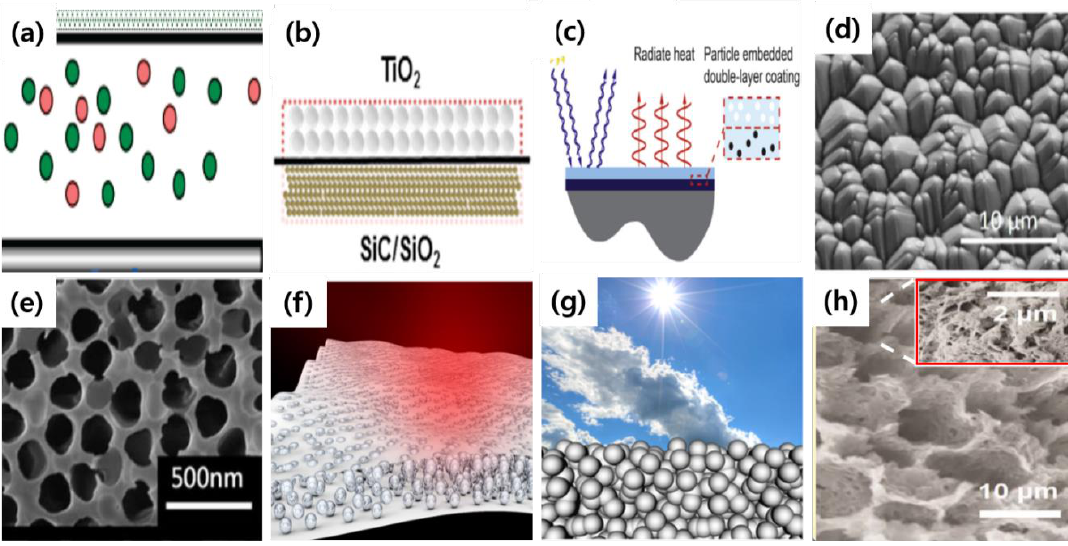
Figure 4. Various random particle-based designs for radiative cooling: ( a , b ) SiC/SiO 2 mixture [7,63], ( c ) acrylic resin in TiO 2 [64], ( d ) SiO 2 random antenna-shaped particles [65], ( e ) random porous structure [69], ( f , g ) SiO 2 microparticles [71,73], and ( h ) porous polymer [74] were reported.